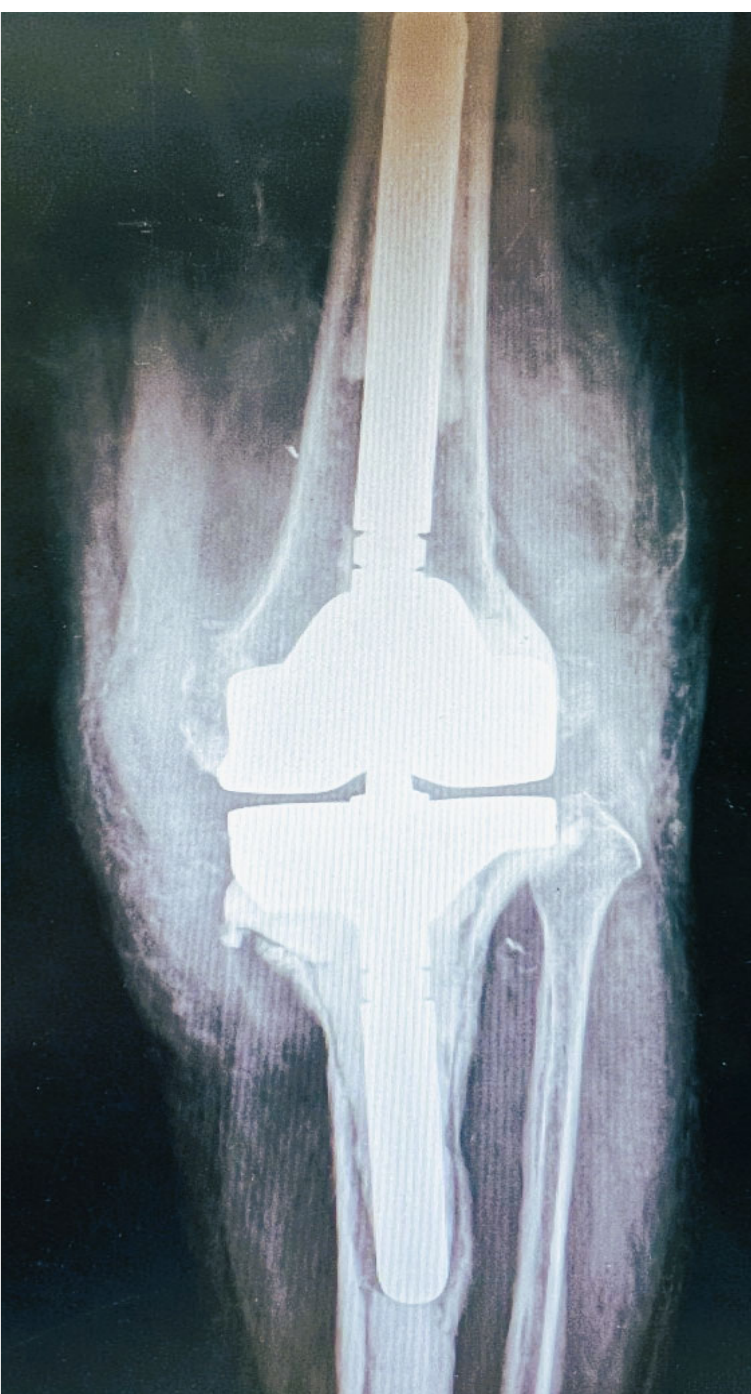
Figure 1. Pre ‐ operative X ‐ ray: anteroposterior view of the revised knee arthroplasty. Loosening is Figure 1. Pre-operative X-ray: anteroposterior view of the revised knee arthroplasty. Loosening is evident especially at the tibia component. evident especially at the tibia